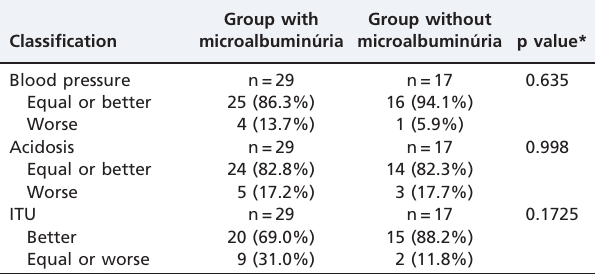
Table 4 - Comparison between the group without microalbuminuria and the group with microalbuminu´ ria regarding blood pressure, metabolic acidosis and number of urinary tract infections during follow up. Classification